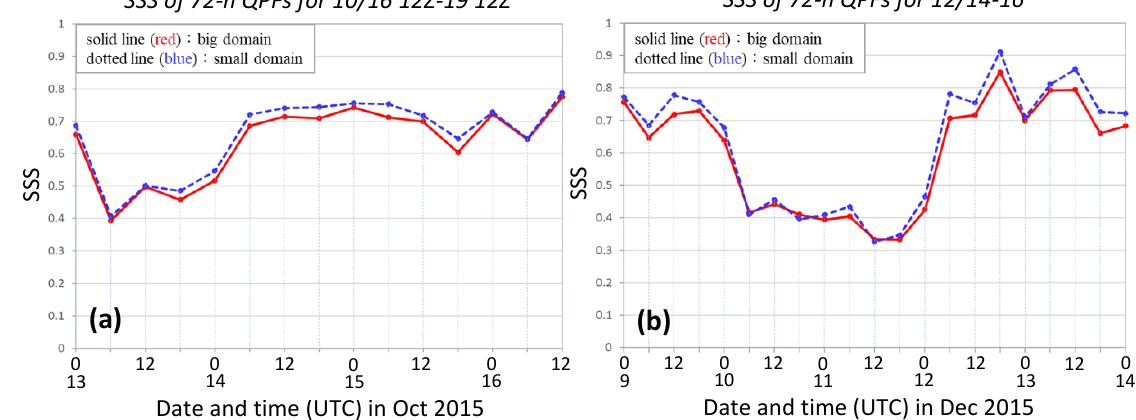
Figure 10. As in Figure 5d, except for SSS of 72 h QPFs for the period of ( a ) 1200 UTC 16–1200 UTC 19 October during TY Koppu (2015) and ( b ) 14–16 December (in UTC) during TY Melor (2015), as functions of initial time for the big and small domains (see Figure 1b).